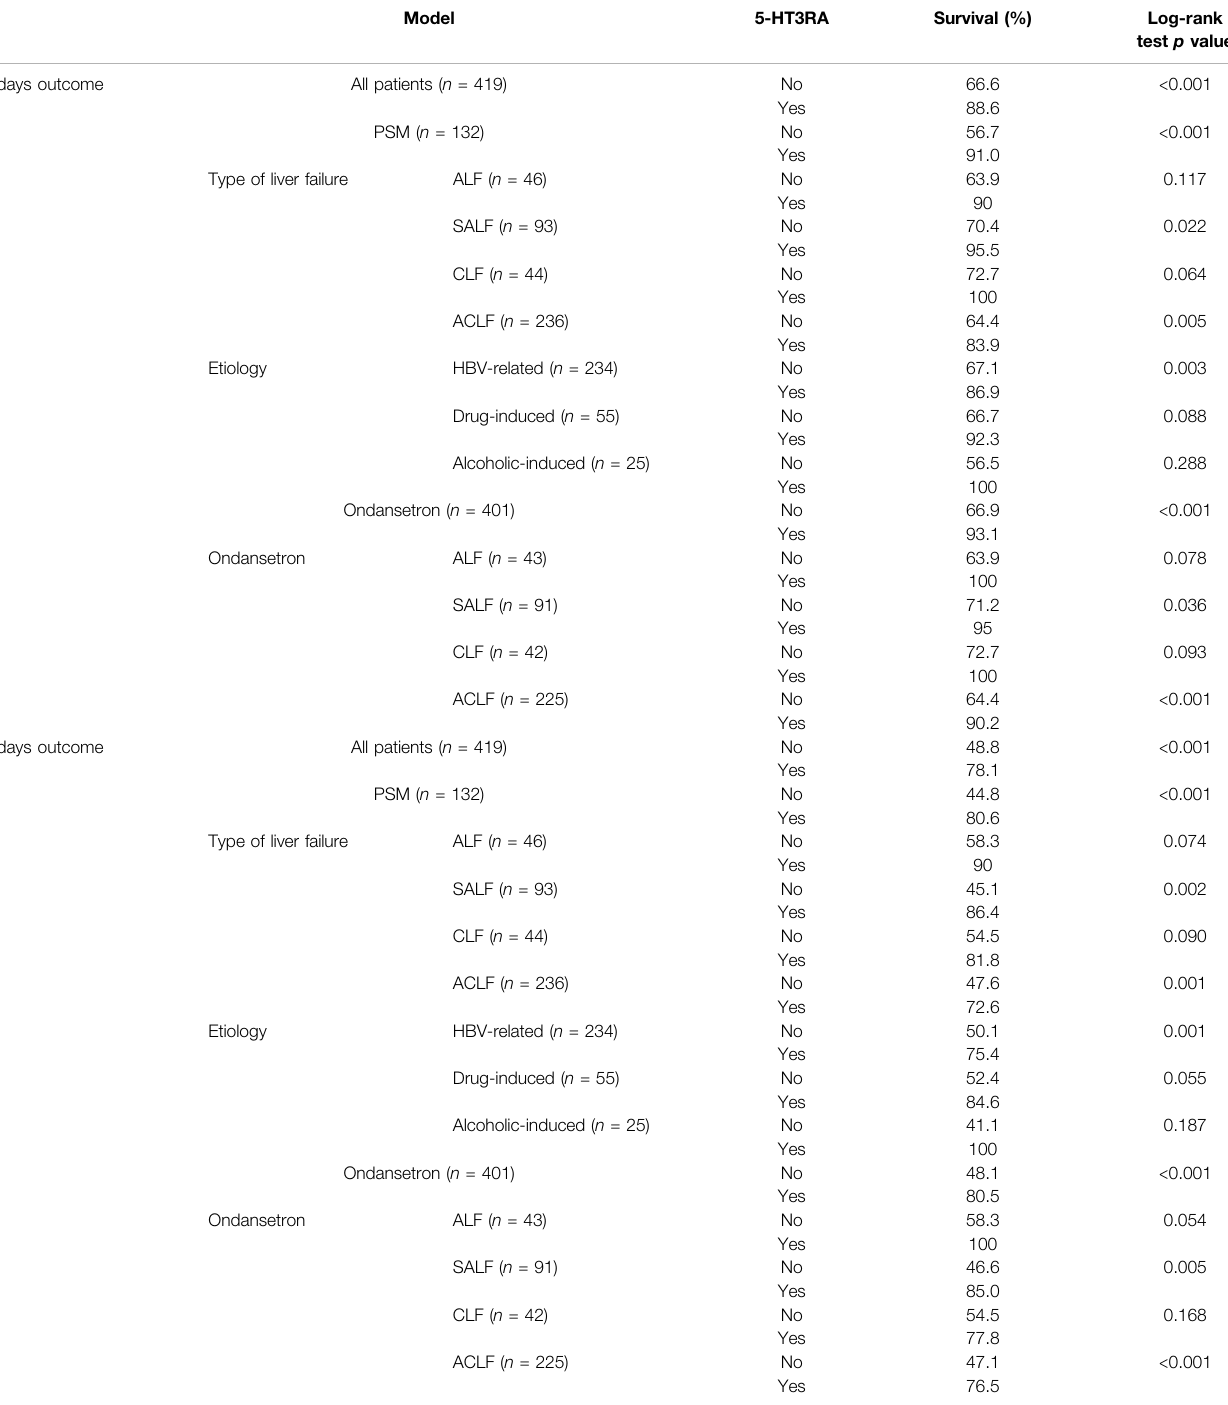
TABLE 4 | Comparison of 28 and 90 days survival for all patients and subgroup patients without (No) and with (Yes) the use of 5-HT3 receptor